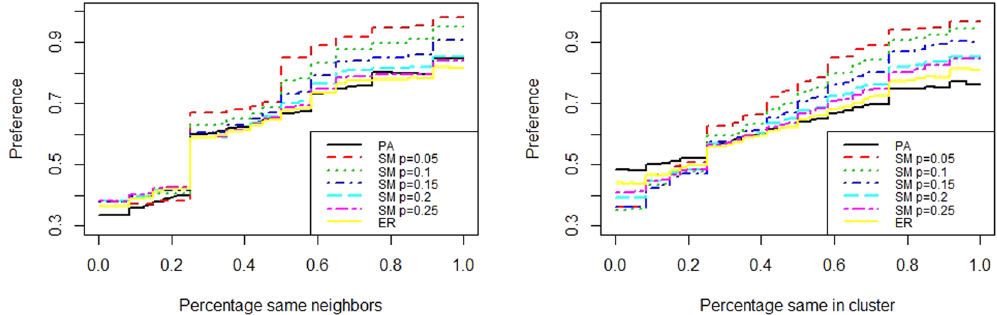
Figure 2. Kernel regression plot, dependent variable preference as a function of, left the fraction of same preference neighbors, right the fraction of same preference nodes in the